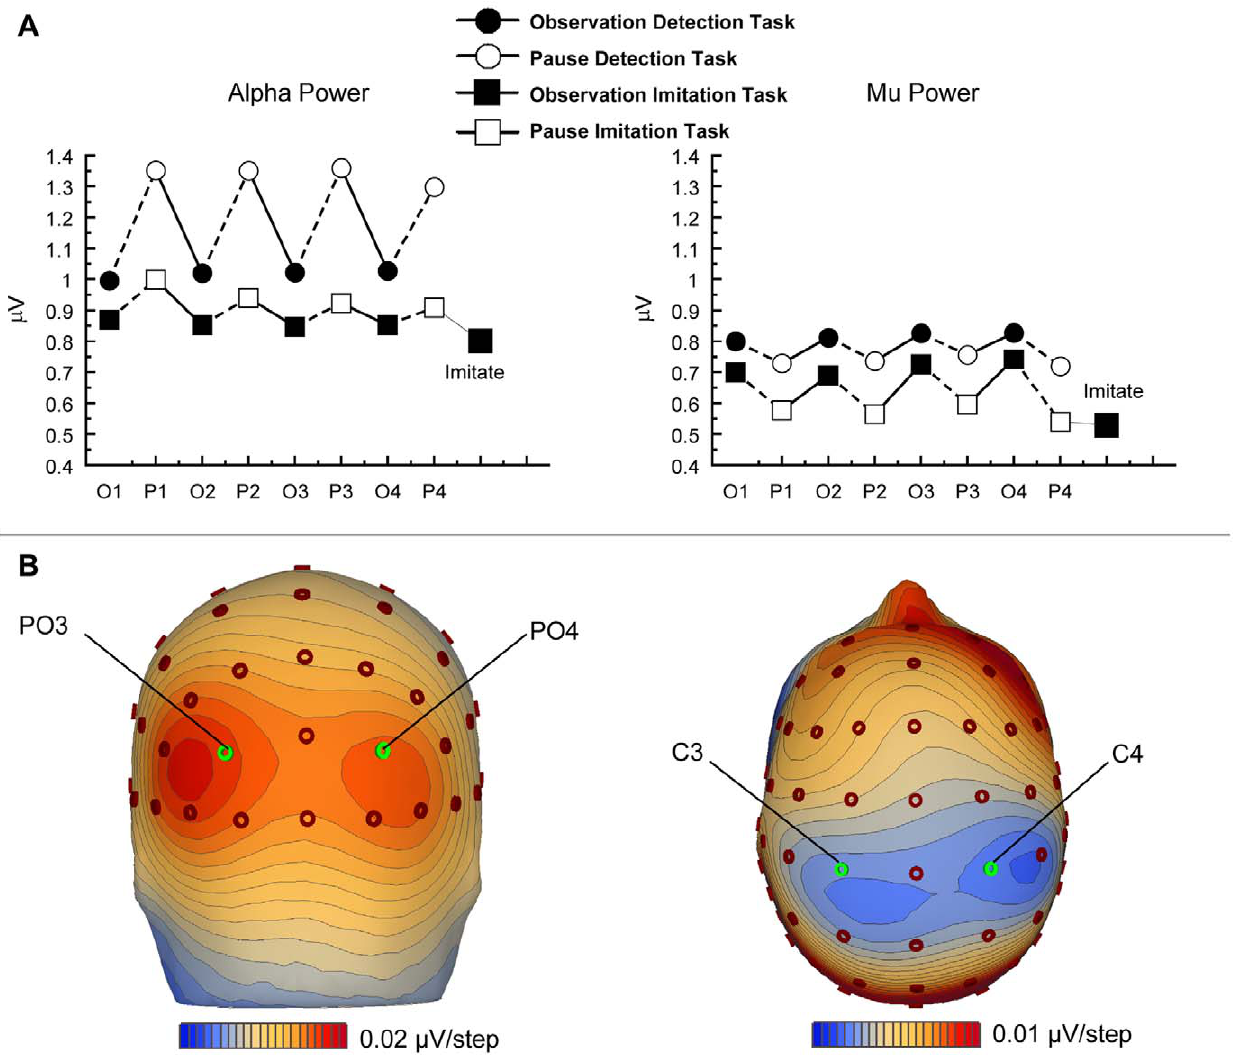
Figure 2. Effects on Alpha and Mu Power. (A) Alpha power (left) and mu power (right) during observation (O1, O2, O3, O4; black symbols) and pause (P1, P2, P3, P4; white symbols) intervals in the imitation task (squares) and the detection task (circles). Squares labelled with ‘‘Imitate’’ represent power levels during execution of the observed movement sequence. (B) Topographic representation of alpha power (left) maximal at bilateral parieto-occipital electrode sites, and mu power (right) overlying the left and right rolandic fissure. Alpha and mu topographies reflect the difference between pause and observation intervals in the detection task and the imitation task, respectively.